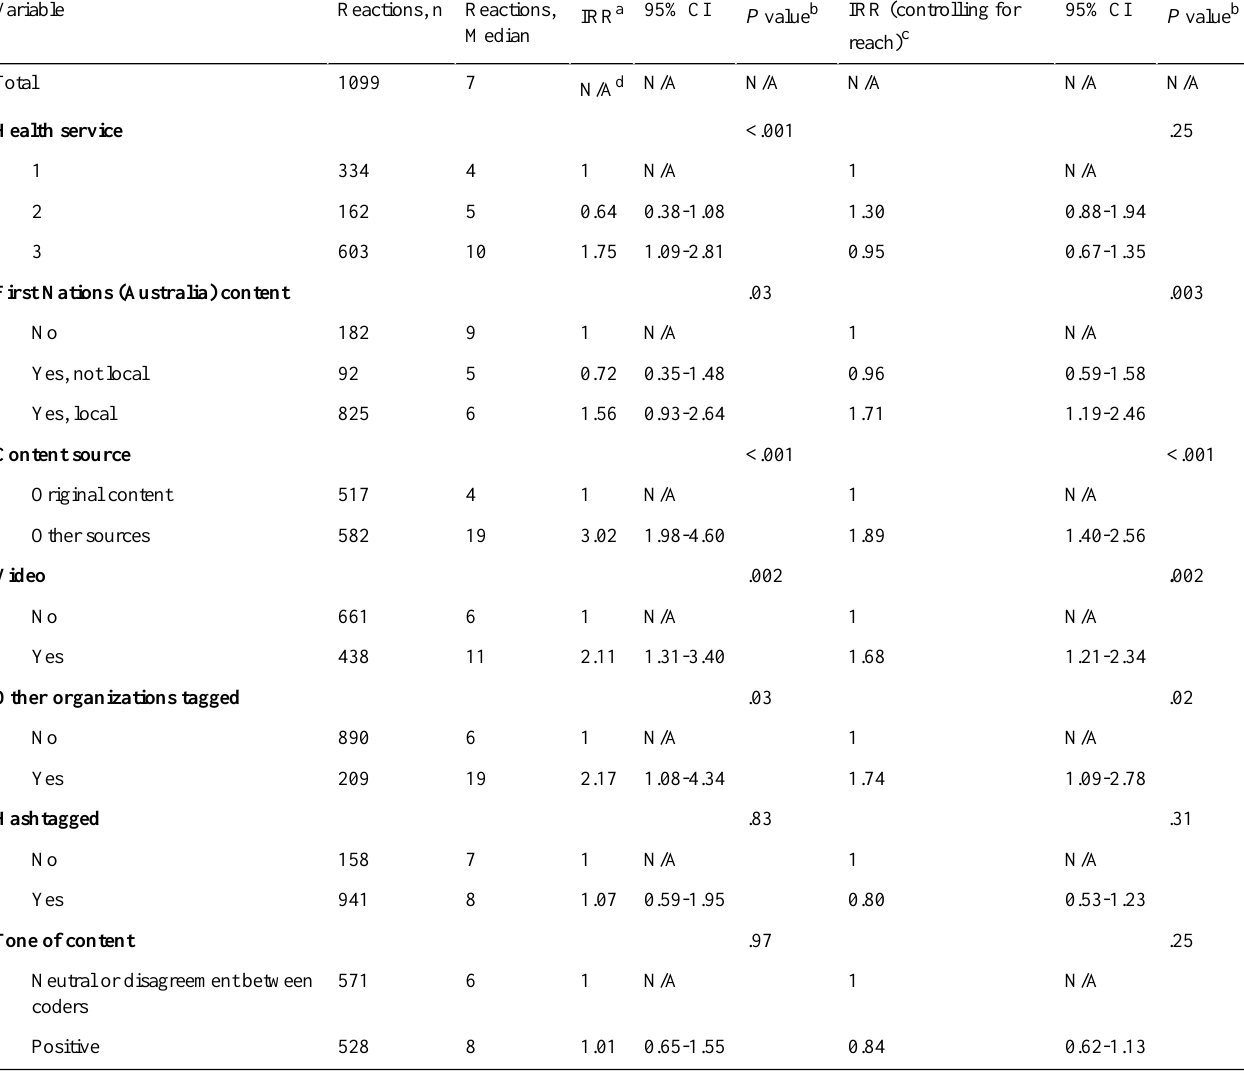
Table 3. Reactions to each type of original post, before and after controlling for reach.